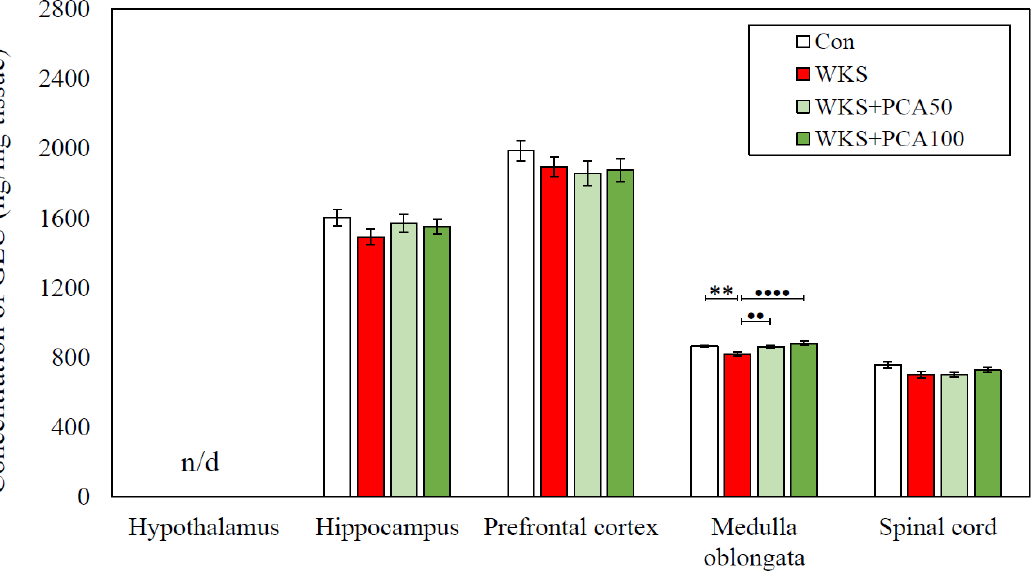
Figure 11. Alanine concentration (mean ± SEM) in selected CNS structures in rats from the control group (Con), the PTD-induced WKS group (WKS), and the PTD-induced WKS groups administered PCA at doses of 50 mg/kg (WKS + PCA50) or 100 mg/kg (WKS + PCA100); * p < 0.05 vs. Con, ** p < 0.01 vs. Con, ••• p < 0.005 vs. WKS, •••• p < 0.001 vs. WKS, n/d — no data (concentration below detection threshold) (ANOVA, post-hoc NK).